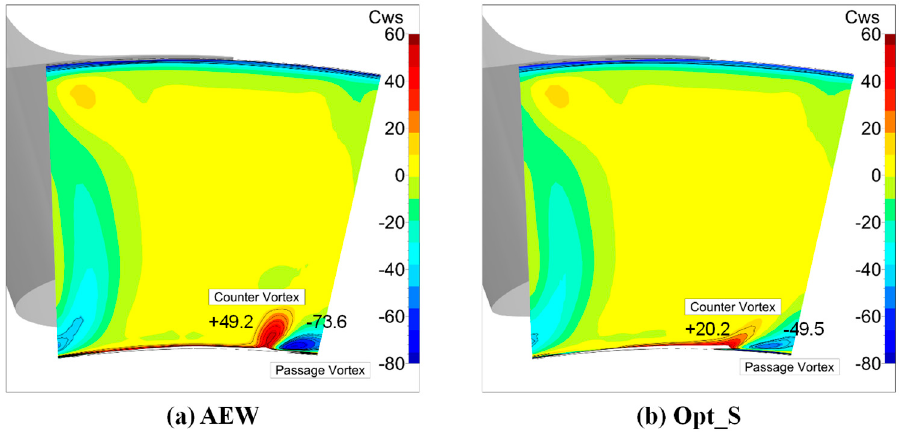
Figure 11. ( a , b ) Contours of normalized streamwise vorticity.